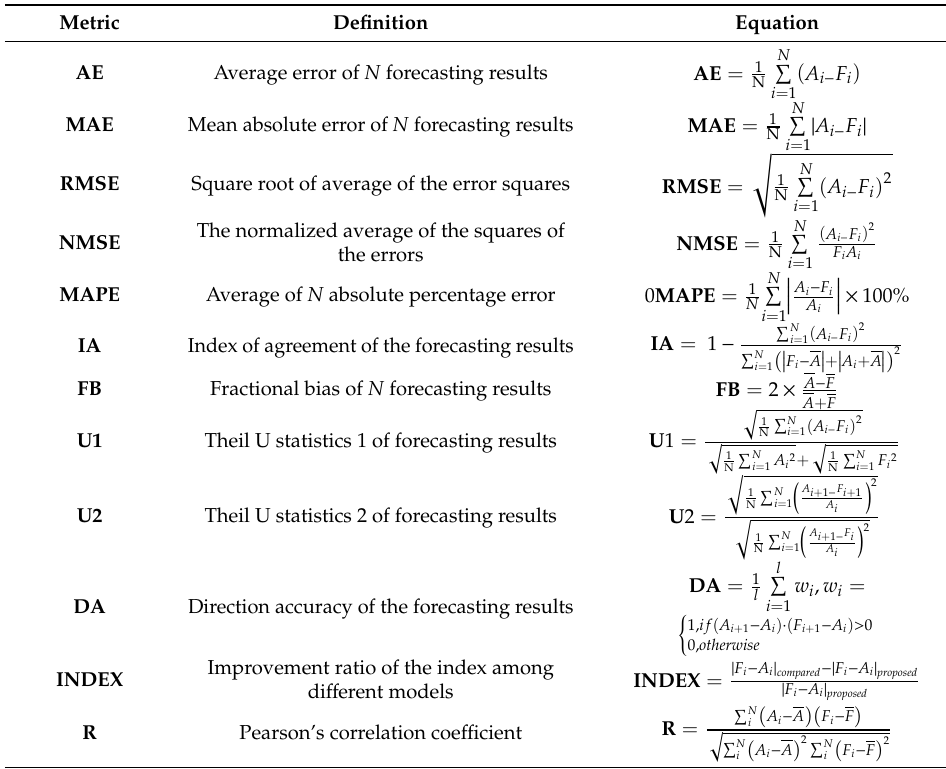
Table 2. Performance metric